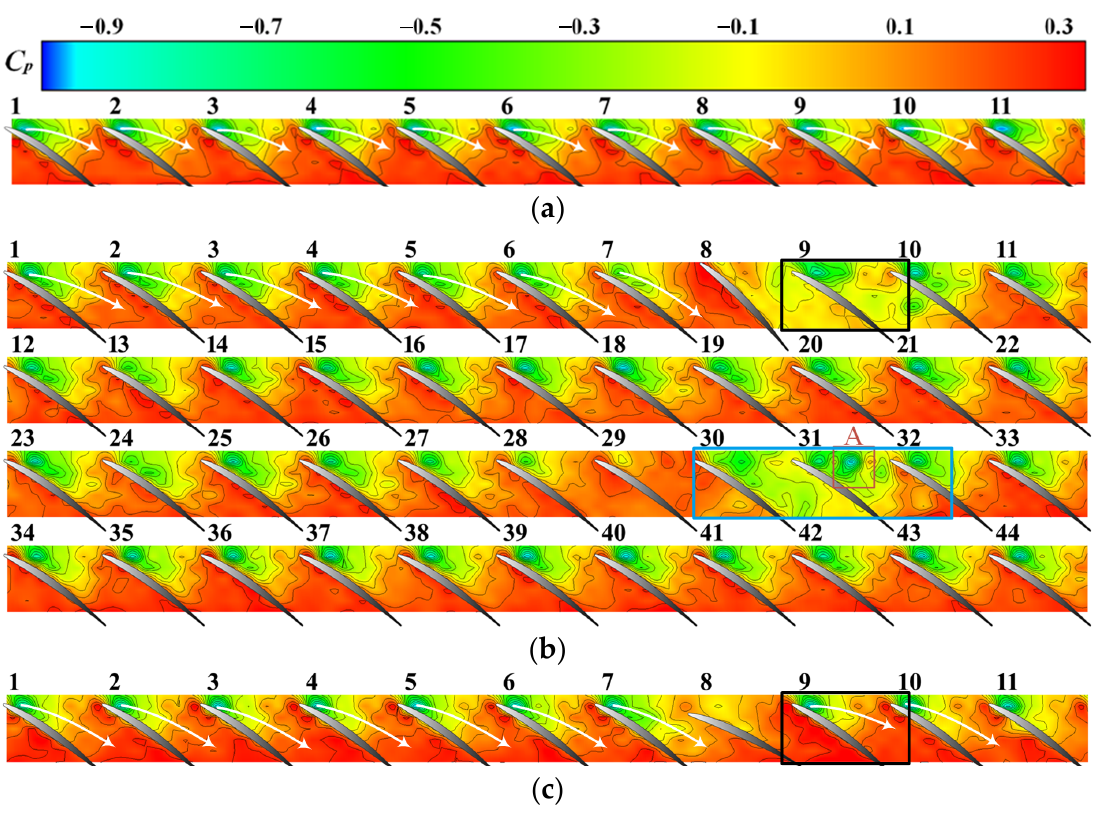
Figure 12. Blade-to-blade casing static pressure contour variability at near-stall condition ( a ) for Case 0, ( b ) for Case 1, and ( c ) for Case 2.